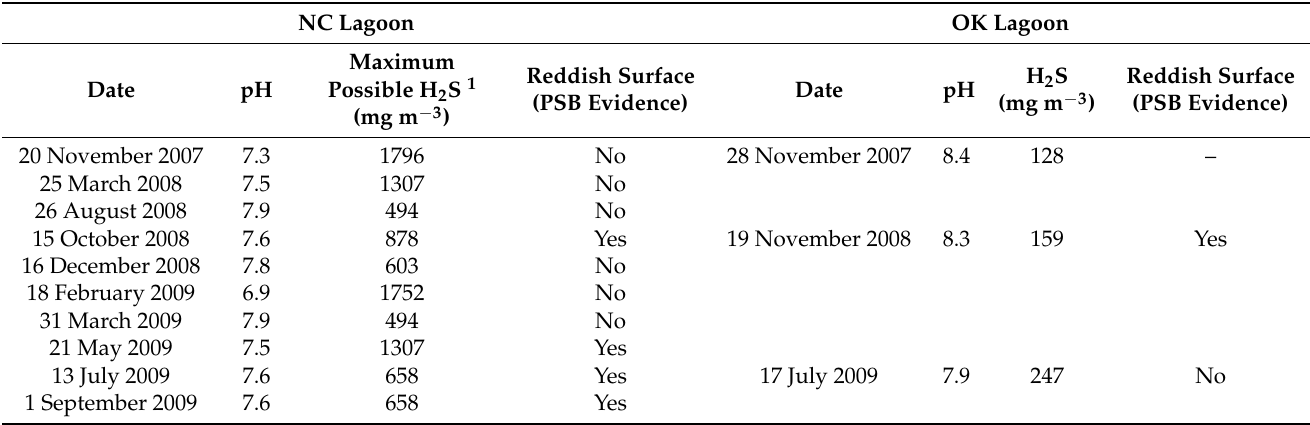
Table 4. Liquid sample chemistry of lagoons associated with PSB